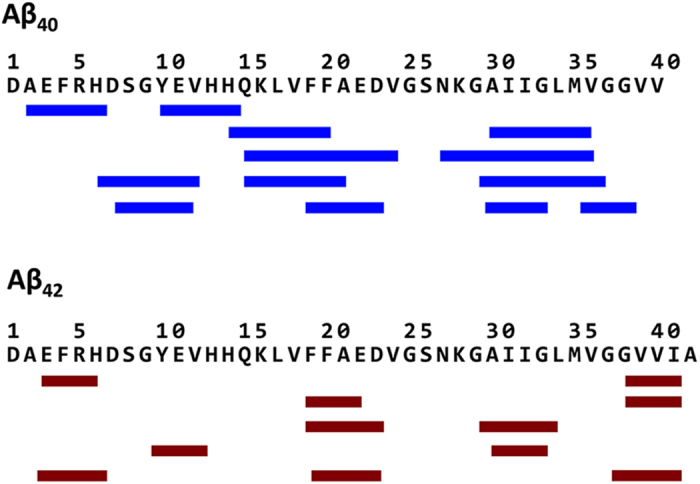
β-sheet associations.The major β-sheet associations observed in the conformation ensembles of Aβ40 and Aβ42 are labelled by strips and paired by lines.